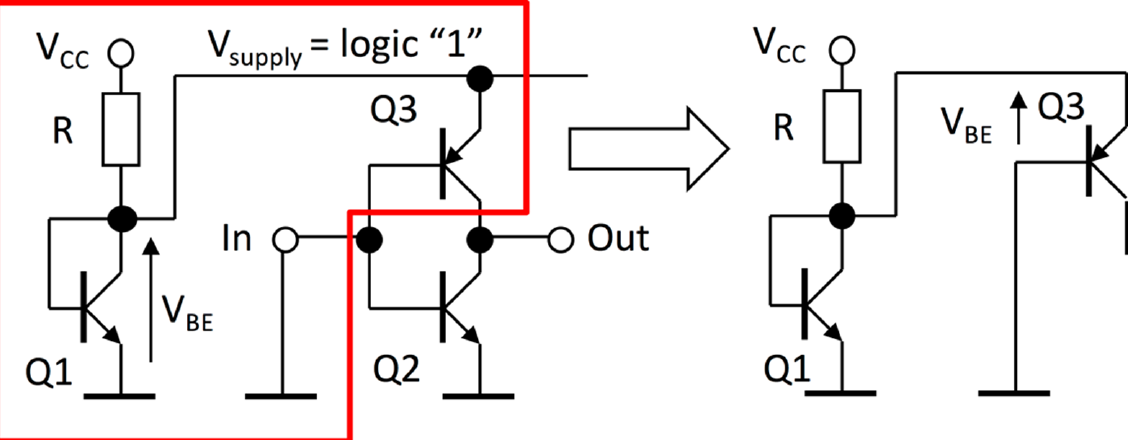
Figure 8. The concept of thermal stabilization of CBip gates: with “0” at the input of the inverter Q1 and Q3 make the current mirror.